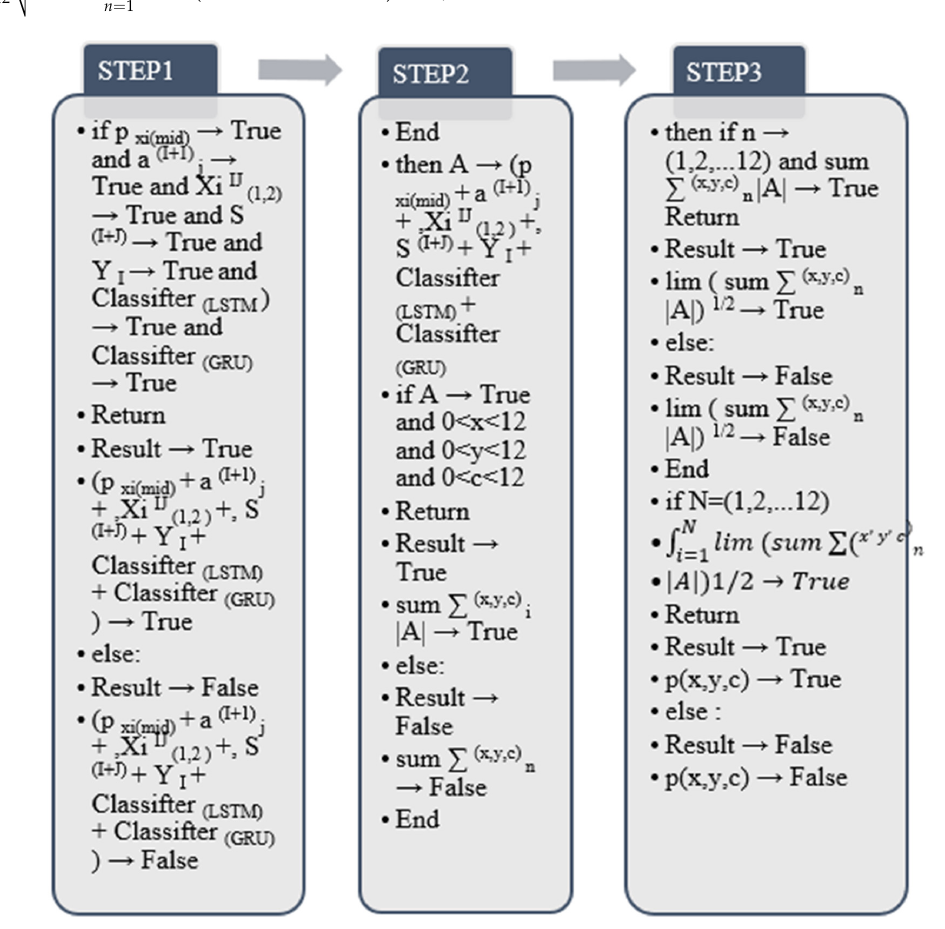
Figure 22. Python main program algorithm output.